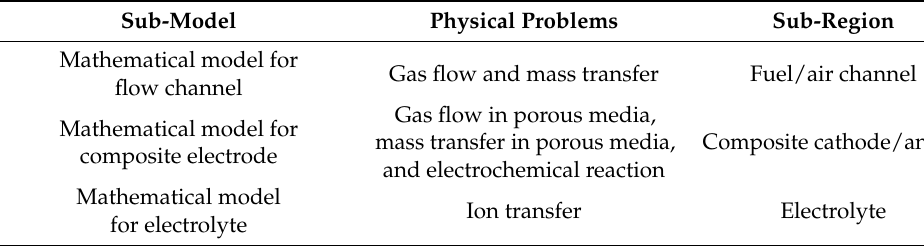
Table 2. Sub-models and regions.